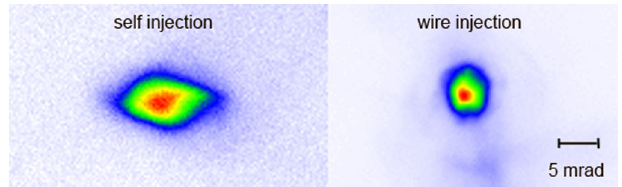
FIG. 4. Beam profile measurements acquired with helium il- lustrate different eccentricities for the two cases without wire on the left and with wire on the right, shown on an equal lateral and normalized color